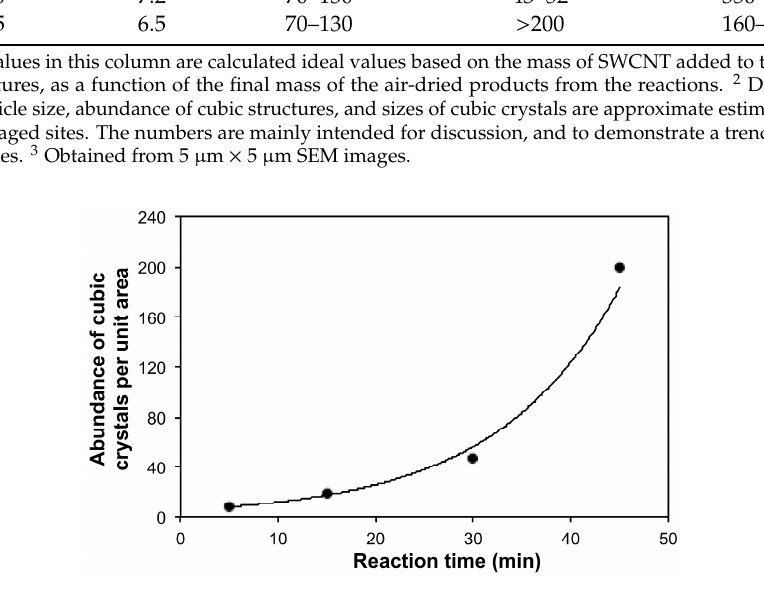
Table 3. Elemental composition (atm.%) of Cu-SWCNT composites prepared by electroless deposition as determined by EDX. 1.